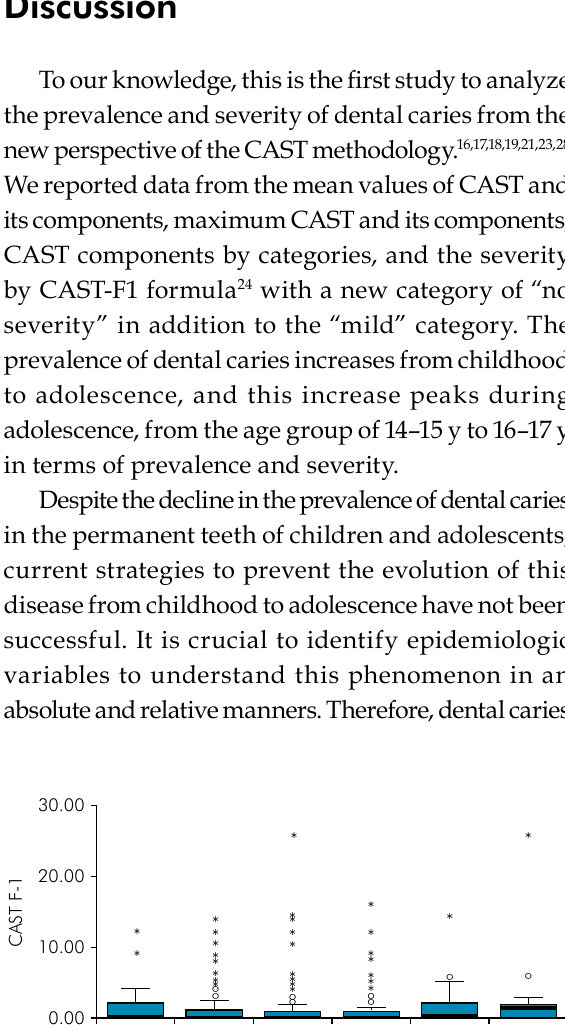
Figure 2. Percentual distribution of the severity score CAST-F1 and its categories, by age group.